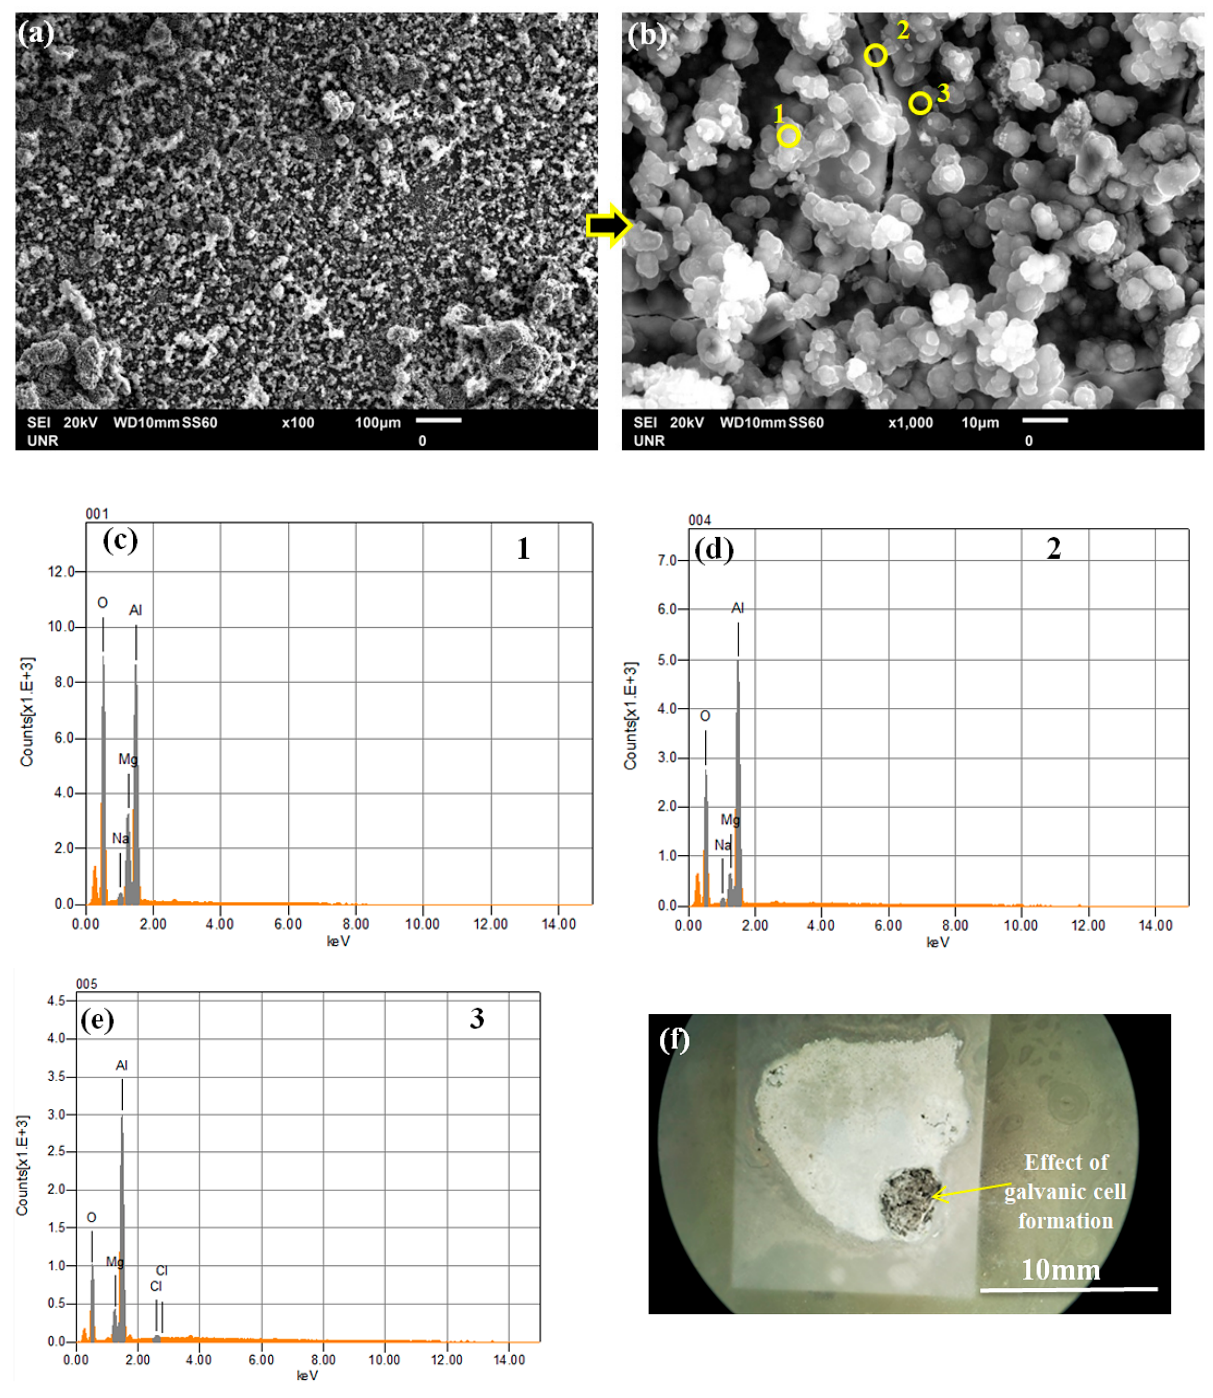
Figure 10. ( a , b ) surface morphology of ground surface of Al-coated AZ31B after immersion test in 3.5 wt % NaCl solution for 11 days, EDS analysis of 1 ( c ), 2 ( d ), 3 ( e ) and ( f ) stereo microscope image at 50× magnification.